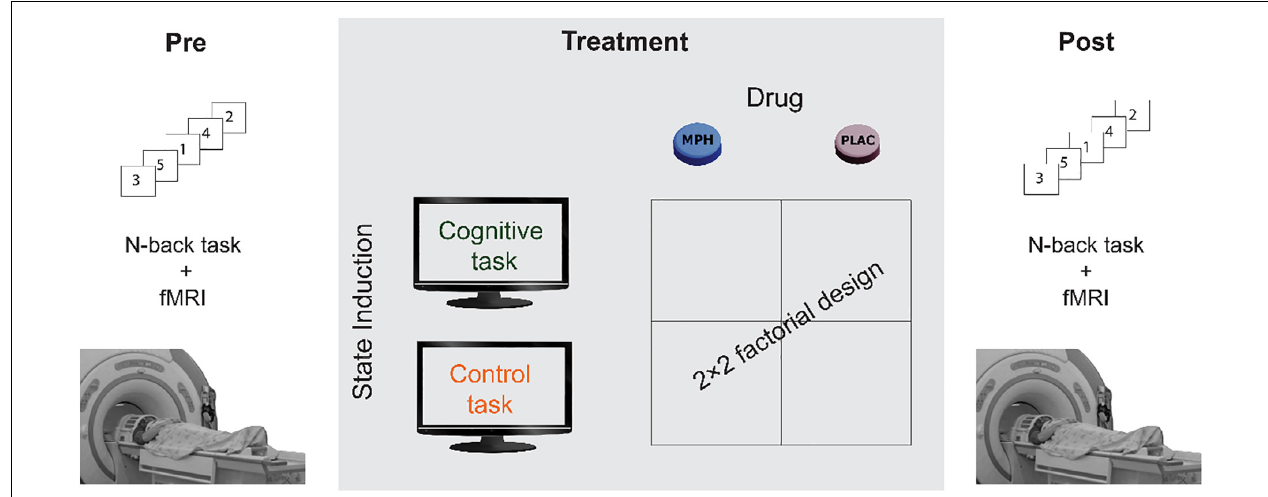
FIGURE 1 | A schematic description of the experimental design. Participants underwent four functional pharmacology counterbalanced sessions in a within-subject 2 × 2 factorial design, resulting in four coupling conditions: Cognitive-MPH, Cognitive-Placebo, Control-MPH, and Control-Placebo. fMRI scanning during the N-Back task was performed before the drug-task coupling procedure and immediately